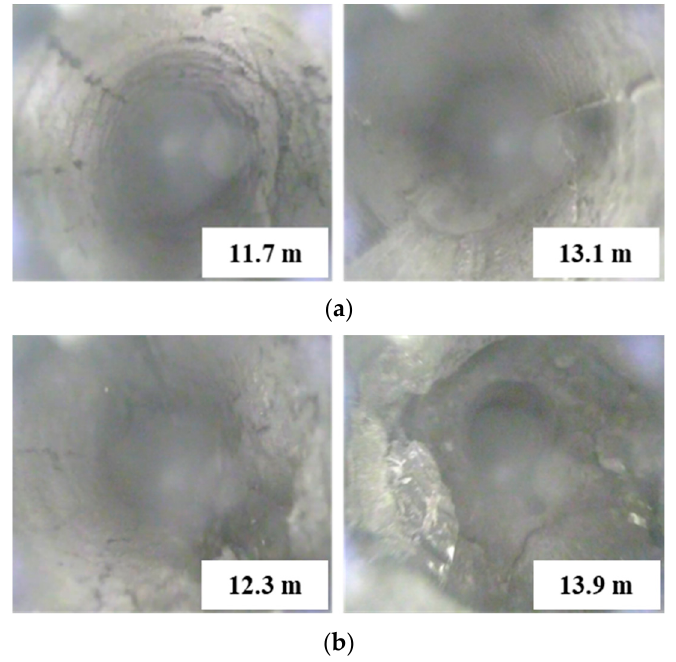
Figure 16. Detection results of the borescope. ( a ) Before fracturing. ( b ) After fracturing.